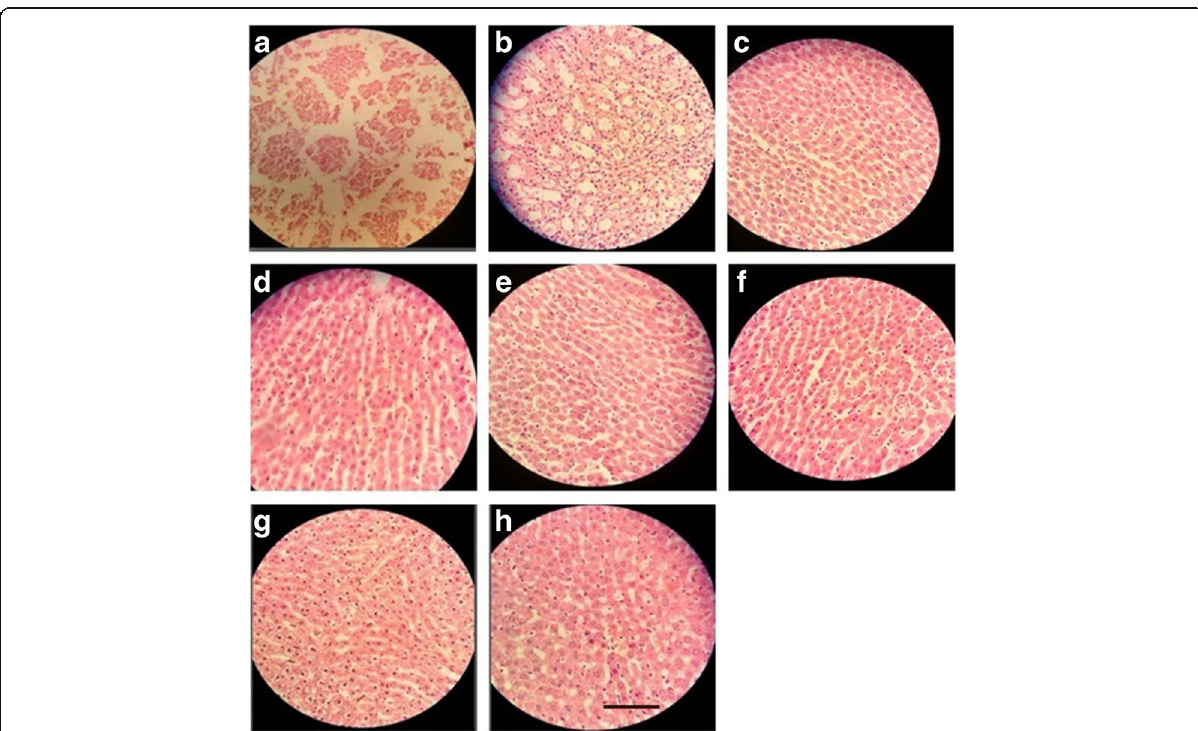
Fig. 5 Histopathological changes in the liver; a : Group I = Normal control, b : Group II = Diabetic wound control, c : Group III = Diabetic wound control +100 mg ethanolic extract of E. hirta , d : Group IV = Diabetic wound control +200 mg ethanolic extract of E. hirta , e : Group V = Diabetic wound control +400 mg ethanolic extract of E. hirta , f : Group VI = Diabetic wound control +5% Povidone iodine, g : Group VII = Diabetic wound control +5% ethanolic extract of E. hirta , h : Group VIII = Diabetic wound control +10% ethanolic extract of E. hirta. Each group was assessed at 400X magnification, scale bar: 40 μ